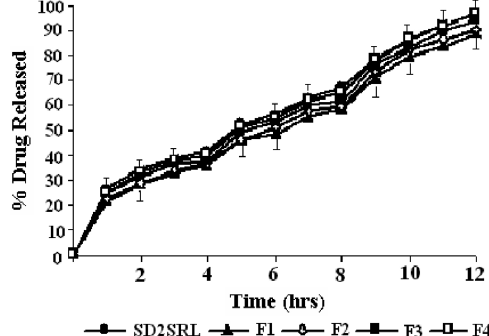
FIGURE 4 - Dissolution Profiles of the SD2SRL Extended Release Solid Dispersion Capsules as Compared to the Profile of the Solid Dispersion